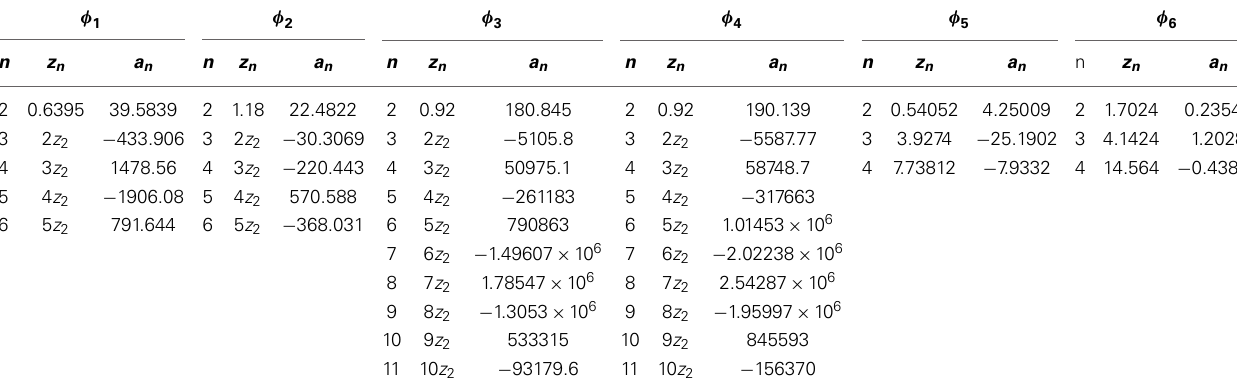
Table 1 | Fitting parameters for φ 1 ( r )- φ 6 ( r ).